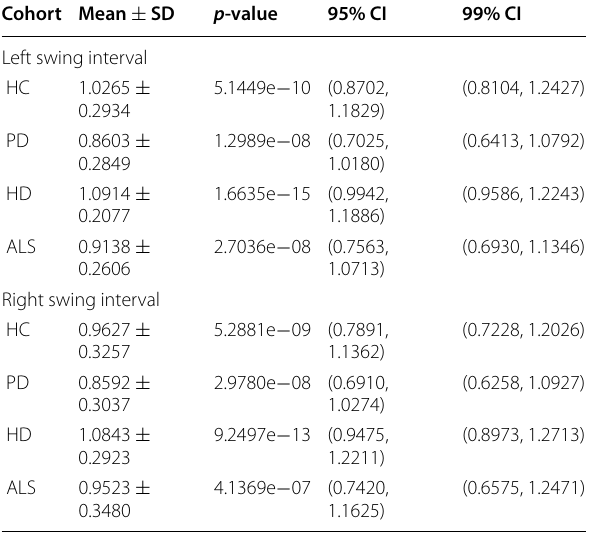
Table 6 Average SampEn values and confidence intervals of left and right swing intervals Cohort Mean ±